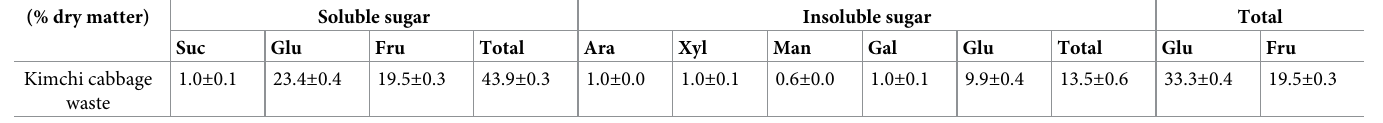
Table 1. Chemical composition of kimchi cabbage waste. (% dry matter)